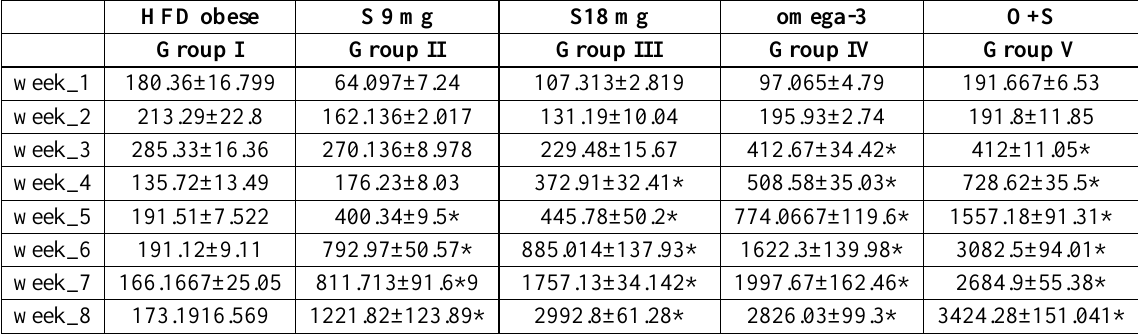
Table 2. Effects of two-different doses of simvastatin, omega-3, and combination of simvastatin and omega3 on the UCP1 gene expression level in white adipose tissue (WAT)